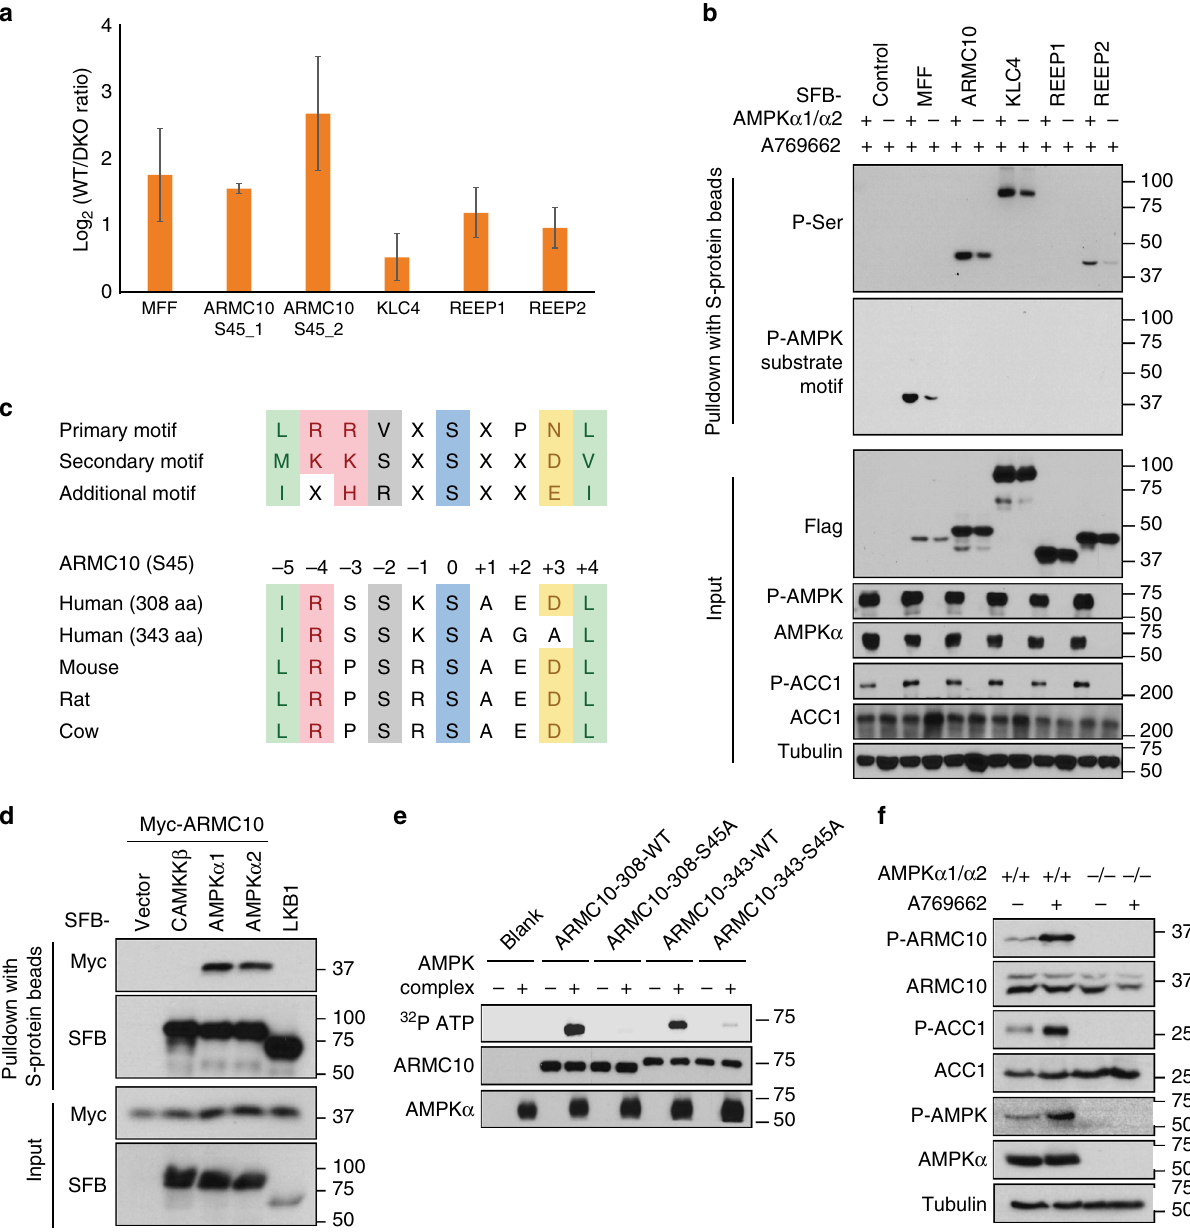
Fig. 3 Validation of AMPK substrates. a Phosphoproteomic quanti fi cation of the fi ve candidate AMPK phosphorylation sites selected for validation. ARMC10 (S45)_1 is the phosphopeptide from the shorter isoform of ARMC10 (308 residues). ARMC10 (S45)_2 is the phosphopeptide from the longer isoform of ARMC10 (343 residues). b Validation of the fi ve selected AMPK substrates. For this experiment, constructs encoding SFB-tagged genes were transfected into WT or AMPK α 1/ α 2 HEK293A cells. Cells were treated 16 h later with AMPK activator A769662 (100 μ M) for 24 h. Cells were collected and subjected to lysis in NETN cell lysis buffer. Cell lysates were subjected to pulldown assay using S protein beads. Western blotting was conducted using indicated antibodies. c Conservation of the phosphorylation site in ARMC10 in mammals. d Association of ARMC10 with AMPK. Constructs